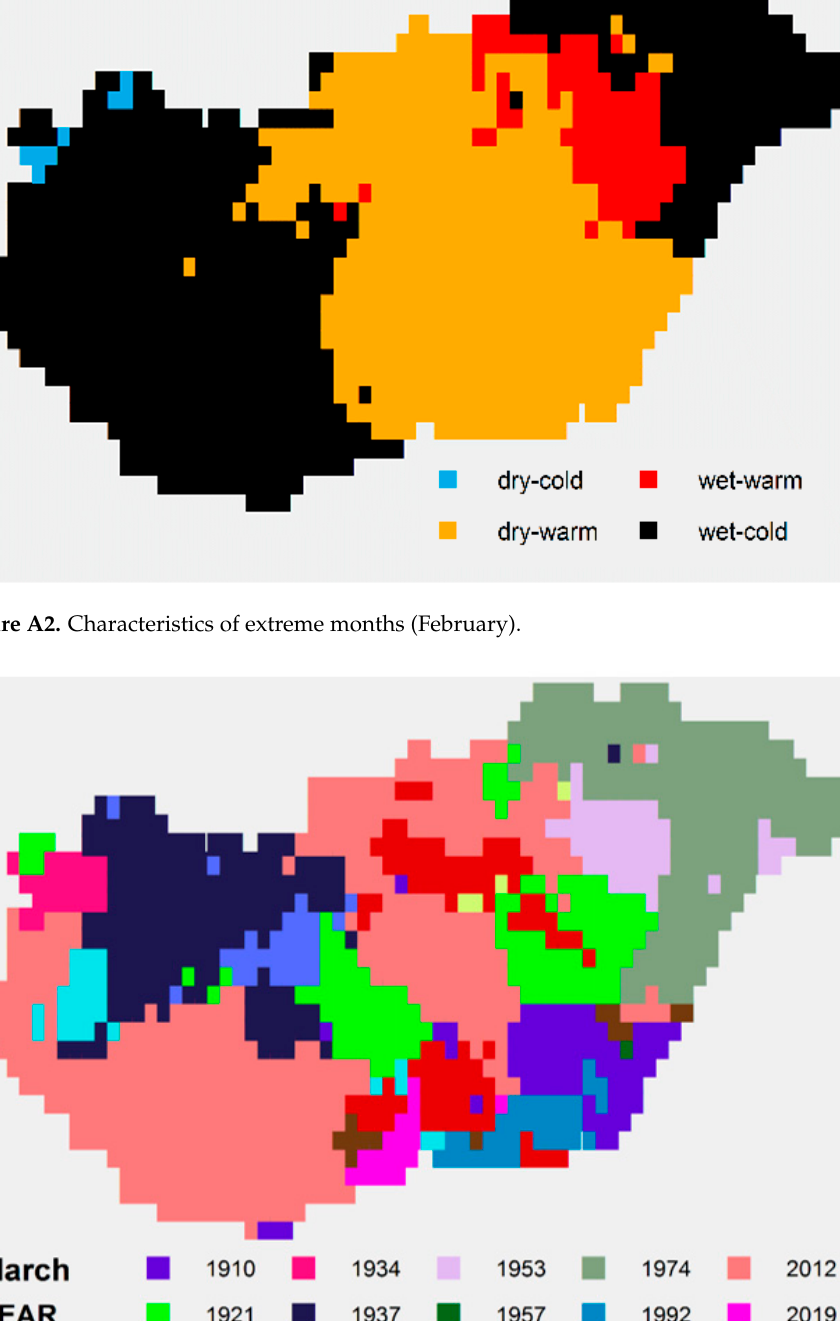
Figure A3. March: Year of maximum SPTI values, 1871–2020.